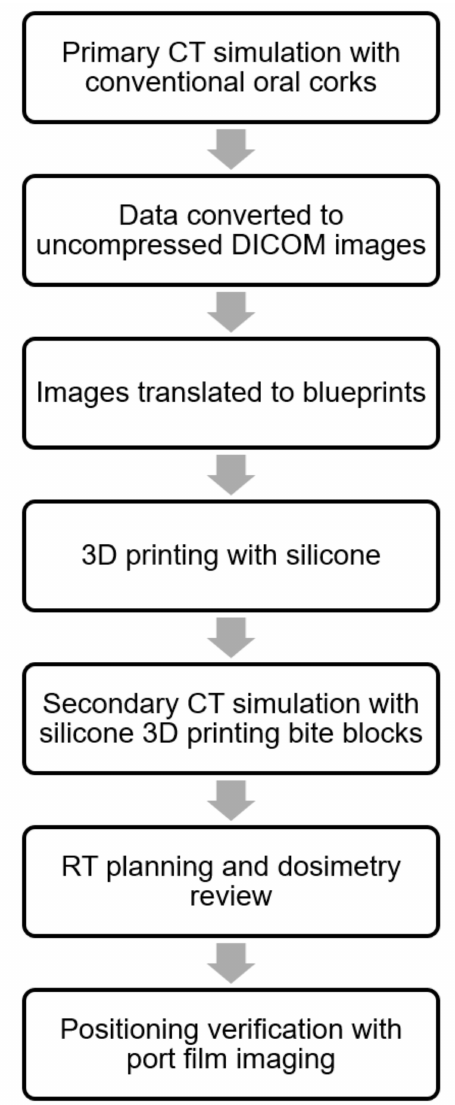
Figure 1. Clinical flow chart showing the steps in the head and neck RT process with the silicone 3D printed bite blocks. First, a primary CT simulation for the head and neck was performed with conventional oral corks; second, the obtained CT images were converted to uncompressed DICOM images; third, the DICOM images were translated into blueprints with the occlusal surface and tongue contoured, and the blueprints were checked by radiation oncologists; fourth, 3D printing with silicone proceeded according to the blueprints; fifth, secondary CT simulation with silicone 3D printed bite blocks was carried out; sixth, RT planning and dosimetry with silicone 3D printed bite blocks was reviewed before treatment; seventh, the patient positioning verification was checked by port film imaging. RT, radiotherapy; 3D, 3-dimensional; CT, computed tomography; DICOM, Digital Imaging and Communications in